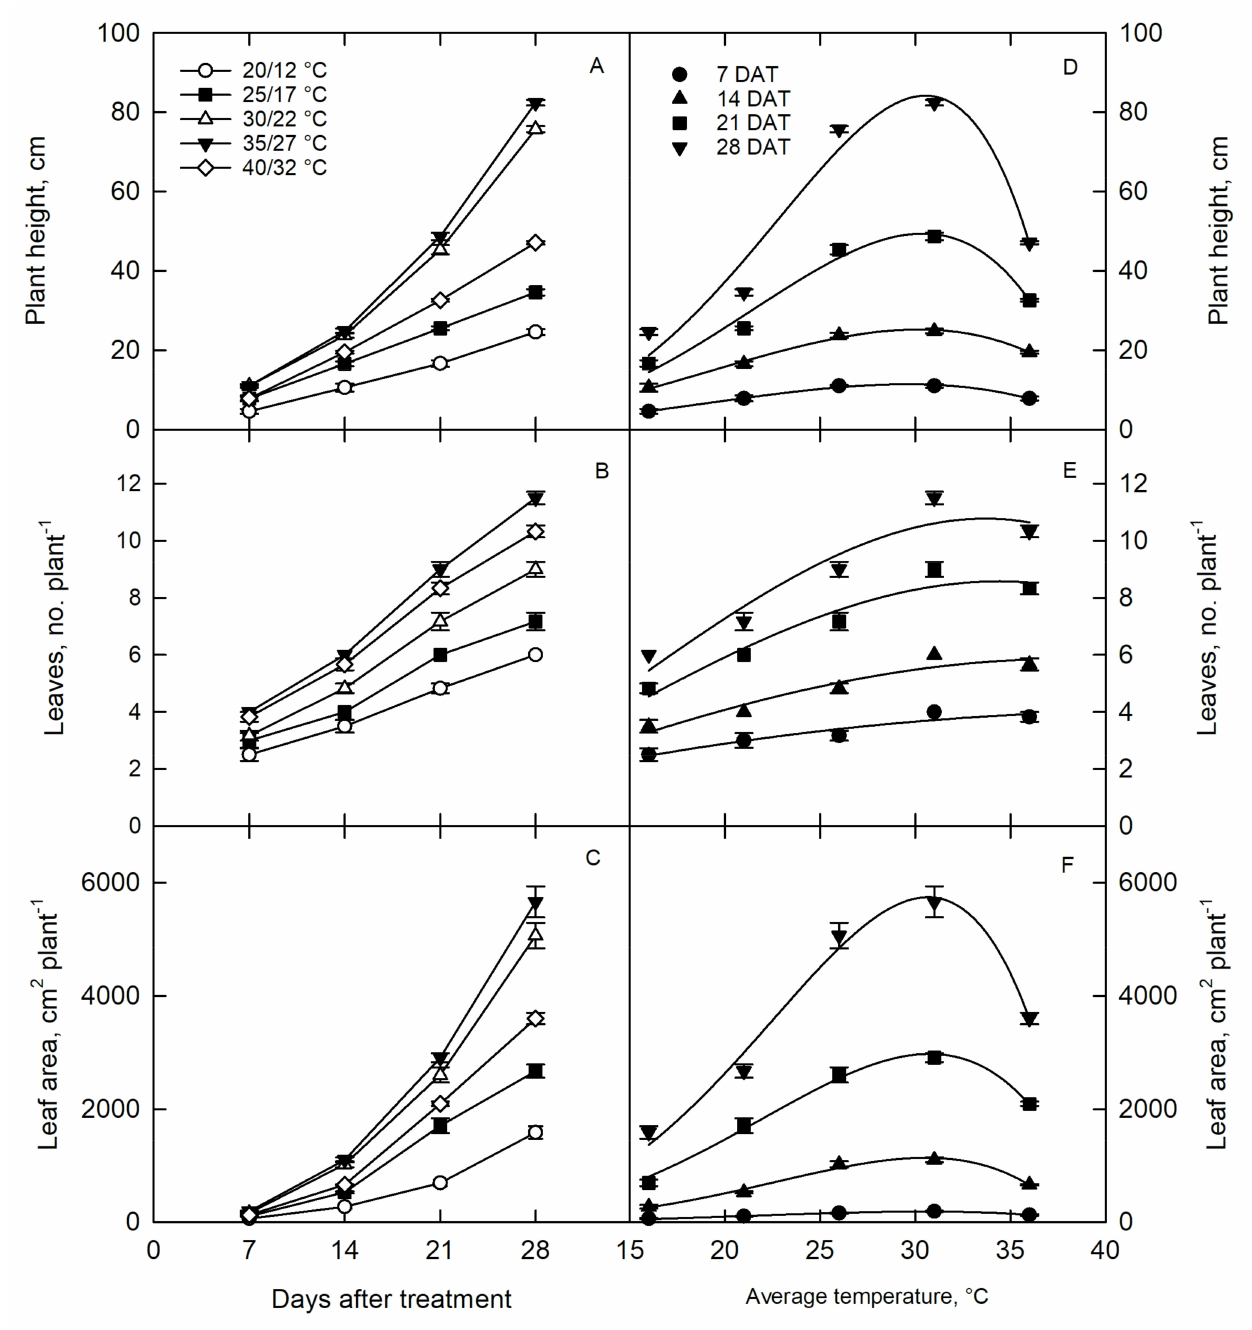
Figure 3. Temporal trends of above-ground corn growth and developmental parameters, ( A ) plant height, ( B ) the number of leaves, and ( C ) leaf area under five differing temperature treatments and estimated growth rates from the weekly measurements as a function of average temperature for ( D ) Stem elongation rate, ( E ) leaf additional rate, ( F ) leaf area expansion rate. The above-ground growth and leaf addition rates fit a modified beta function model. All values are the mean ± standard error of six replications at each harvest under each